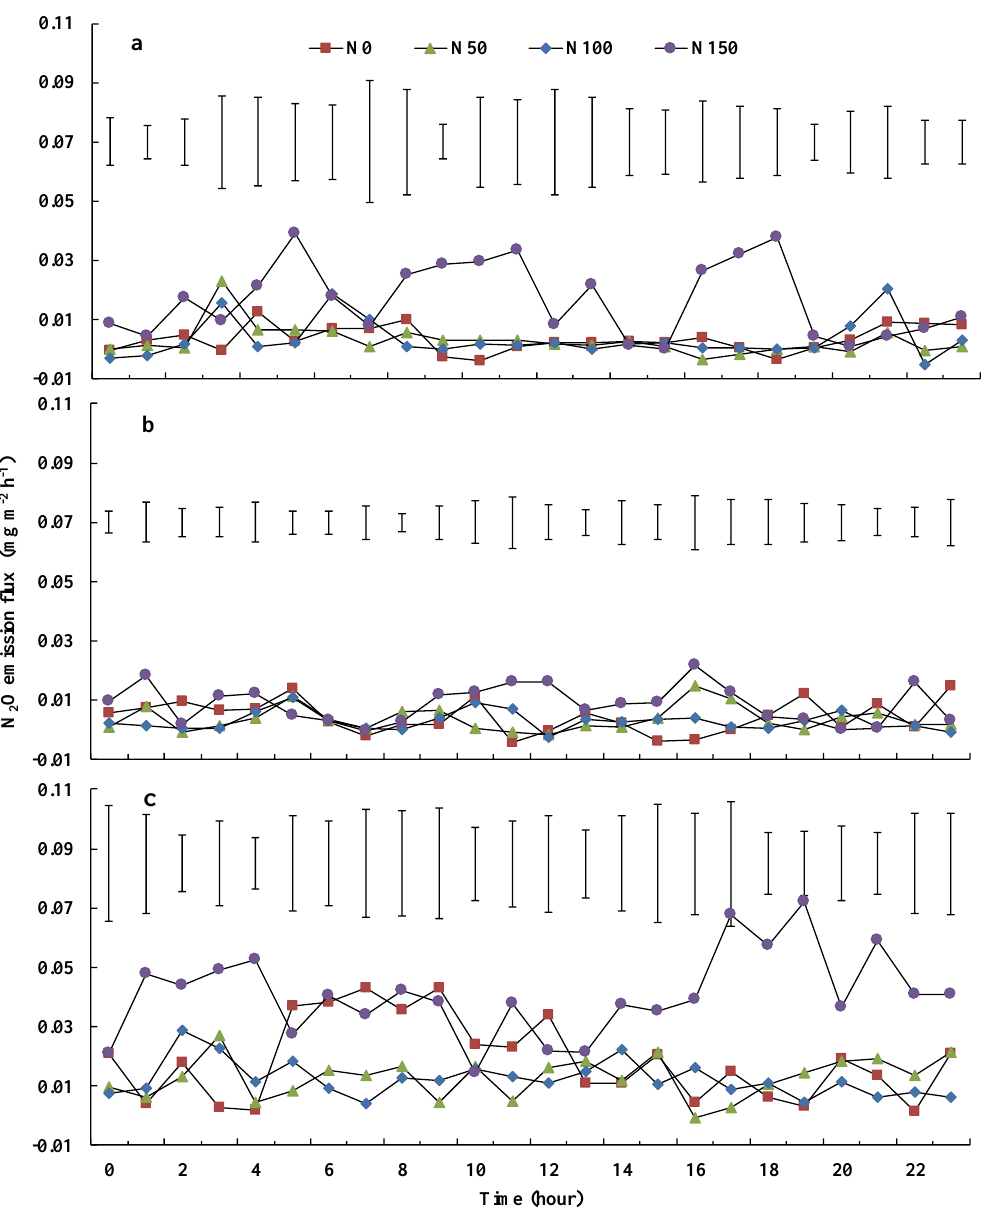
Figure 5. N 2 O emission daily dynamics of four nitrogen addition treatments on Day 2 ( a ), Day 4 ( b ) and Day 6 ( c ). Bars represent the LSD (p = 0.05) values between four nitrogen levels on each hour, n = 3.